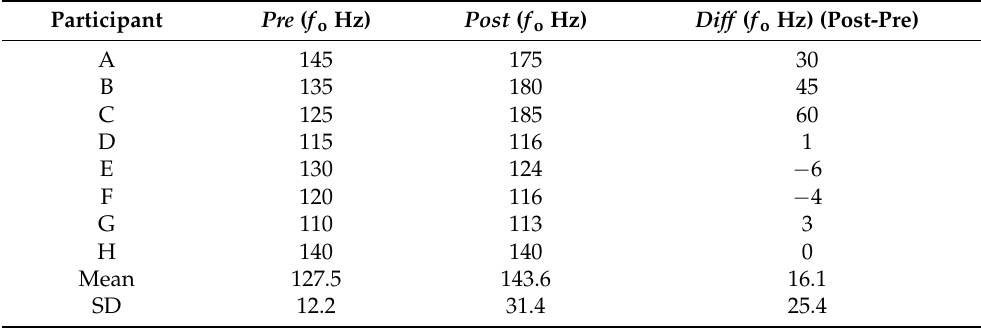
Figure 2. Example 2. Panel A ( left ): Boxplots over the sample’s fundamental frequencies (in Hz) before ( pre ) and after ( post ) training. Panel B ( right ): Individual treatment “trajectories”. Each participant’s pre and post measure is color-coded per participant and illustrated with a circle connected by a straight line. In both figures, 180 Hz is illustrated as a horizontal dashed line because it has been suggested to be fundamental frequency range relevant for being perceived as a female speaker [24–26] which is the goal of the participants. Table 2. Example 2. Each individual’s average fundamental frequency (in Hz) before ( pre ) and after ( post ) treatment. The right-most column is the post minus pre difference in Hz. Further illustrated are the mean and standard deviation for each column. Because the inter-individual variation in the difference scores is so large as only some participants have large treatment effects, a t -test applied to the mean difference is not statistically significant. t 7 = 1.8, p = 0.12. The standardized mean difference, Cohen’s d , is 0.64.